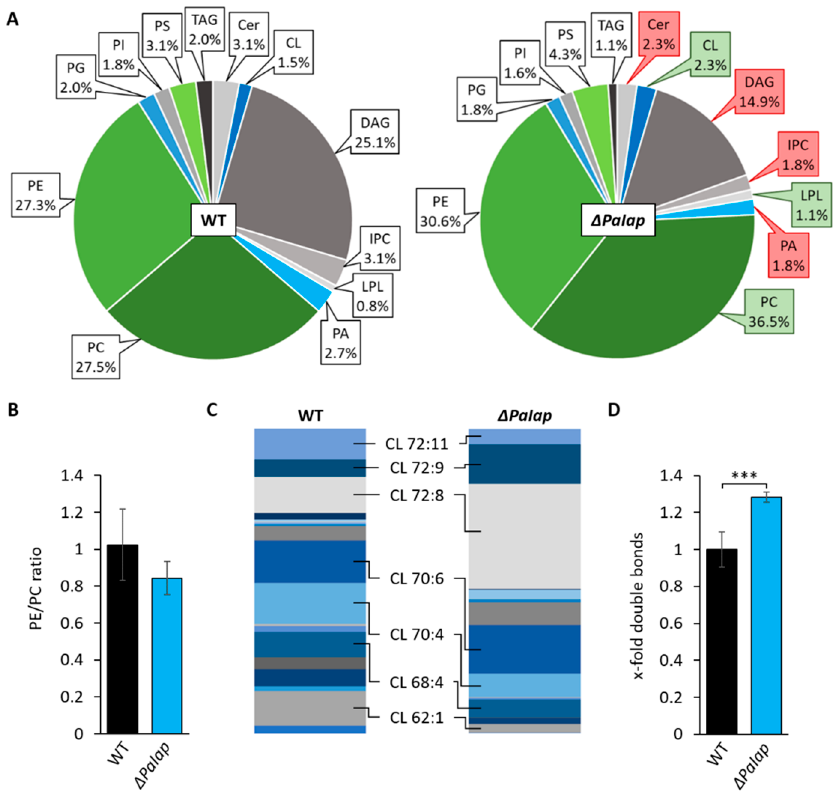
Figure 4. Deletion of PaIap alters mitochondrial lipid profile. ( A ): Comparative PL composition of isolated mitochondria of 7-day-old wild-type (WT) strains and Δ PaIap mutants grown under glycolytic conditions. Data represent relative proportion of total lipids. Significantly ( p < 0.05) increased or reduced PLs are marked with green and red boxes, respectively. Exact values can be found in supplementary material (Table S1). For abbreviations, see caption of Figure 1. ( B ): PE/PC ratio of WT and Δ PaIap . Data represent mean ± SD (n = 5). ( C ): Graphical illustration of relative proportions of different CL species in wild type (WT) and Δ PaIap according to total length of all 4 acyl chains (58–72) and total degree of unsaturation (1–11), e.g., CL 72:8. The displayed species represent a selection of the most abundant CL variants in both strains (proportion > 8%). ( D ): Comparative analysis of total double bonds across all CL species. Total amount of double bonds in CL species was related to wild type (set to 1). Data represent mean ± SD (n = 5). *** p < 0.001. Exact values can be found in supplementary material (Table S2).